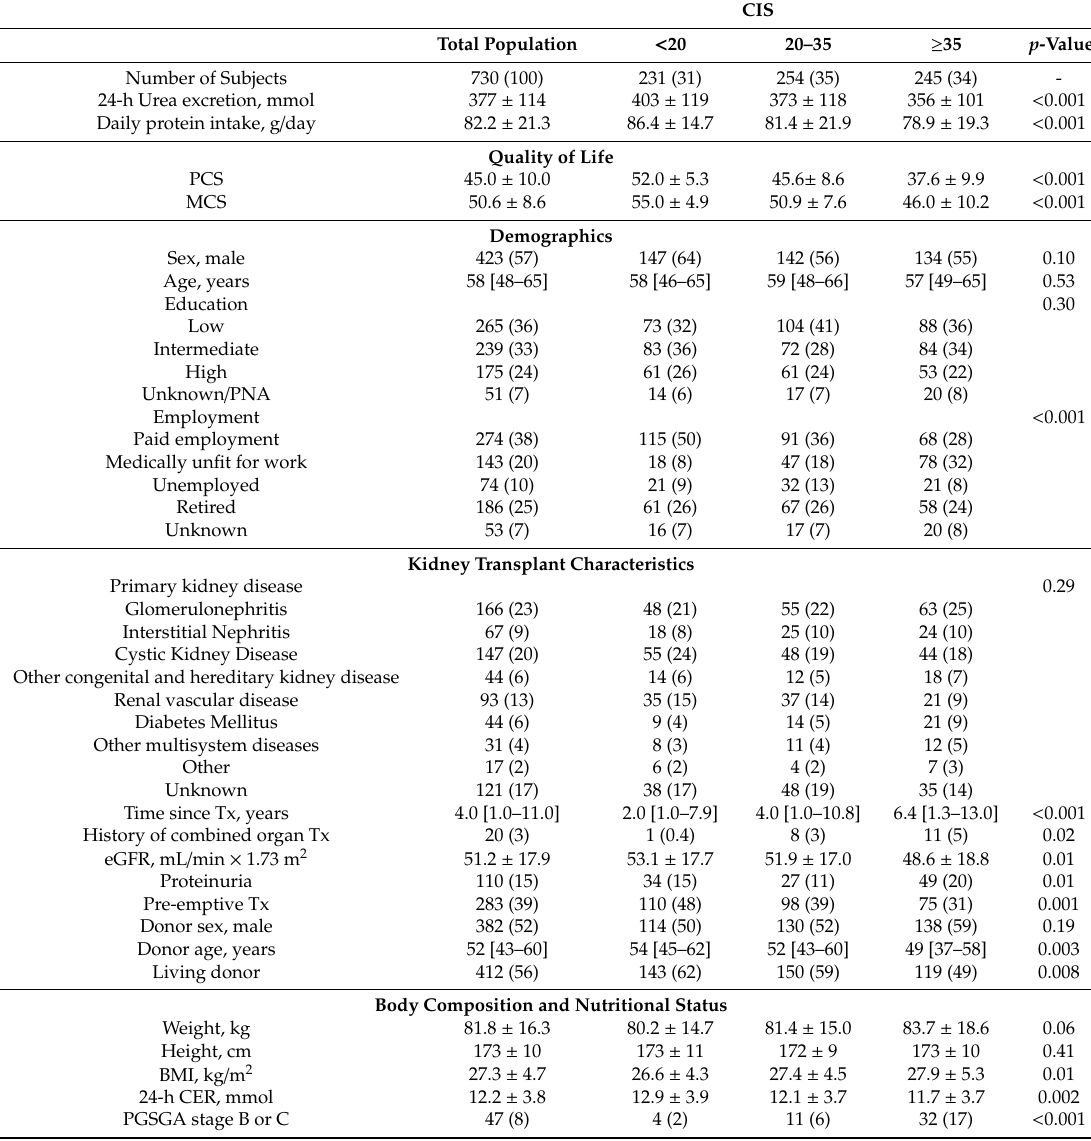
Table 1. Baseline characteristics of 730 KTR and di ff erences according to categories of